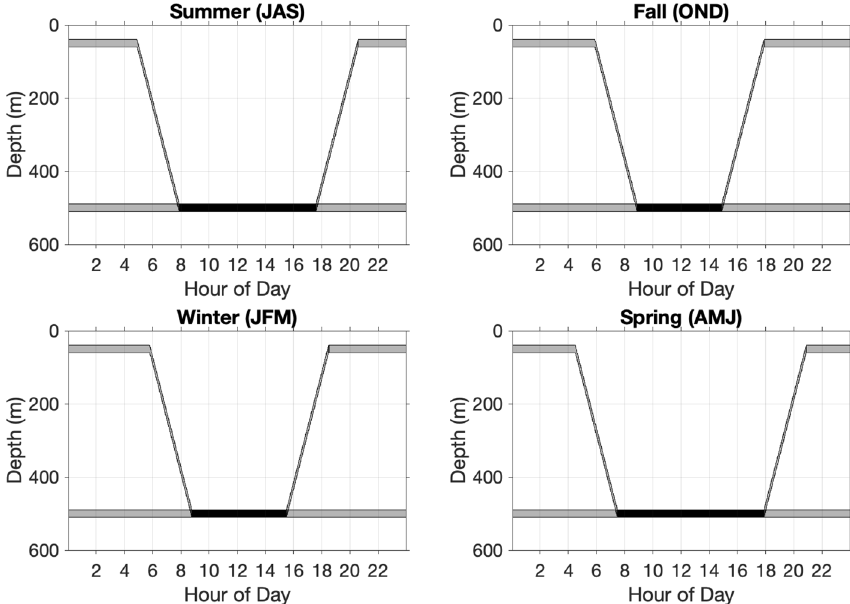
Figure 2. Representative organism migration curves for each season. Migration times change with sunrise and sunset for each season. This illustration assumes that 50% of individuals migrate. The shading shows the percentage of individuals with black indicating 100%, i.e., all organisms, and grey indicating 50%. These numbers vary among the